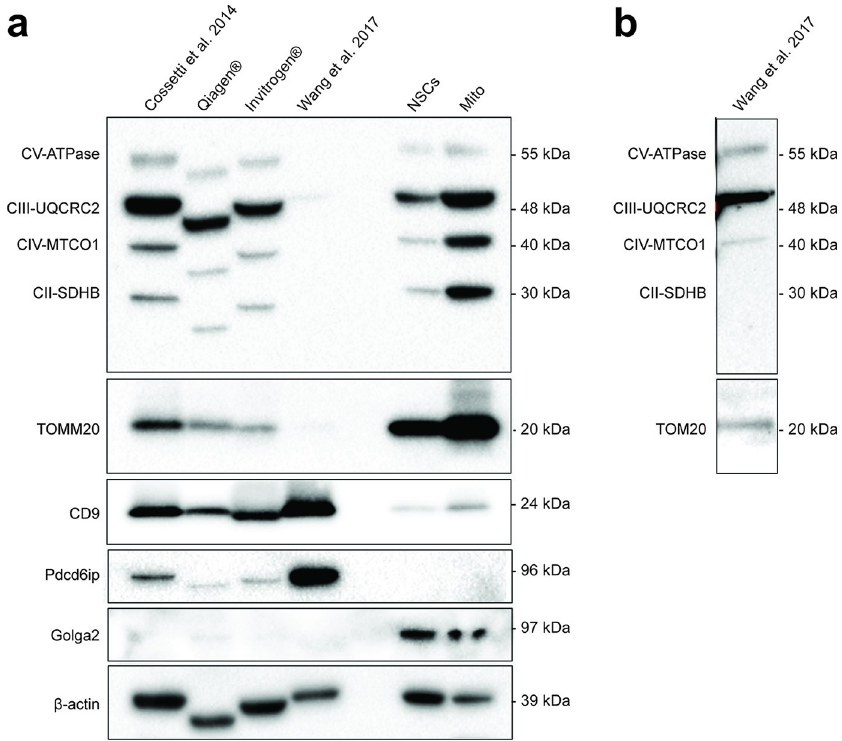
Fig 2. Quality controls of EVs. (a) Protein expression by WB analysis of EVs isolated using in house protocol, with commercial kits (Qiagen cat. No 76743 and Invitrogen cat. No 4478359), and an alternative protocol with an additional 0.22 μ m ultrafiltration step. NSCs and isolated mitochondria (Mito) are used as comparative controls. Mitochondrial complexes proteins (CV-ATPase, CII-SDHA, CII-SDHB, CIV-MTCO1, and CIII-UQCRC2), mitochondrial outer membrane translocase (TOMM20), and exosomal positive (Pdcd6ip and CD9) and negative (Golga2) markers are shown, as well as β -actin. (b) Longer exposure of the lane containing the EVs isolated with the alternative protocol with an additional ultrafiltration step showing mitochondrial proteins. EV, extracellular vesicle; NSC, neural stem cell; WB, western